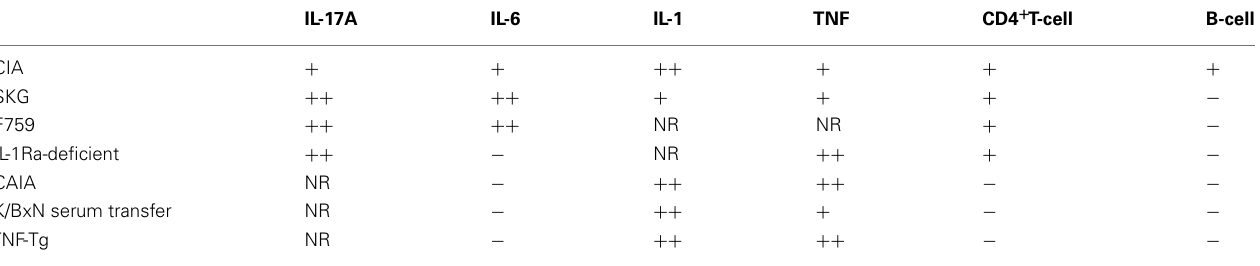
Table 1 |The contribution of proinflammatory cytokines and lymphocytes to the development of mouse models of RA. IL-17A IL-6